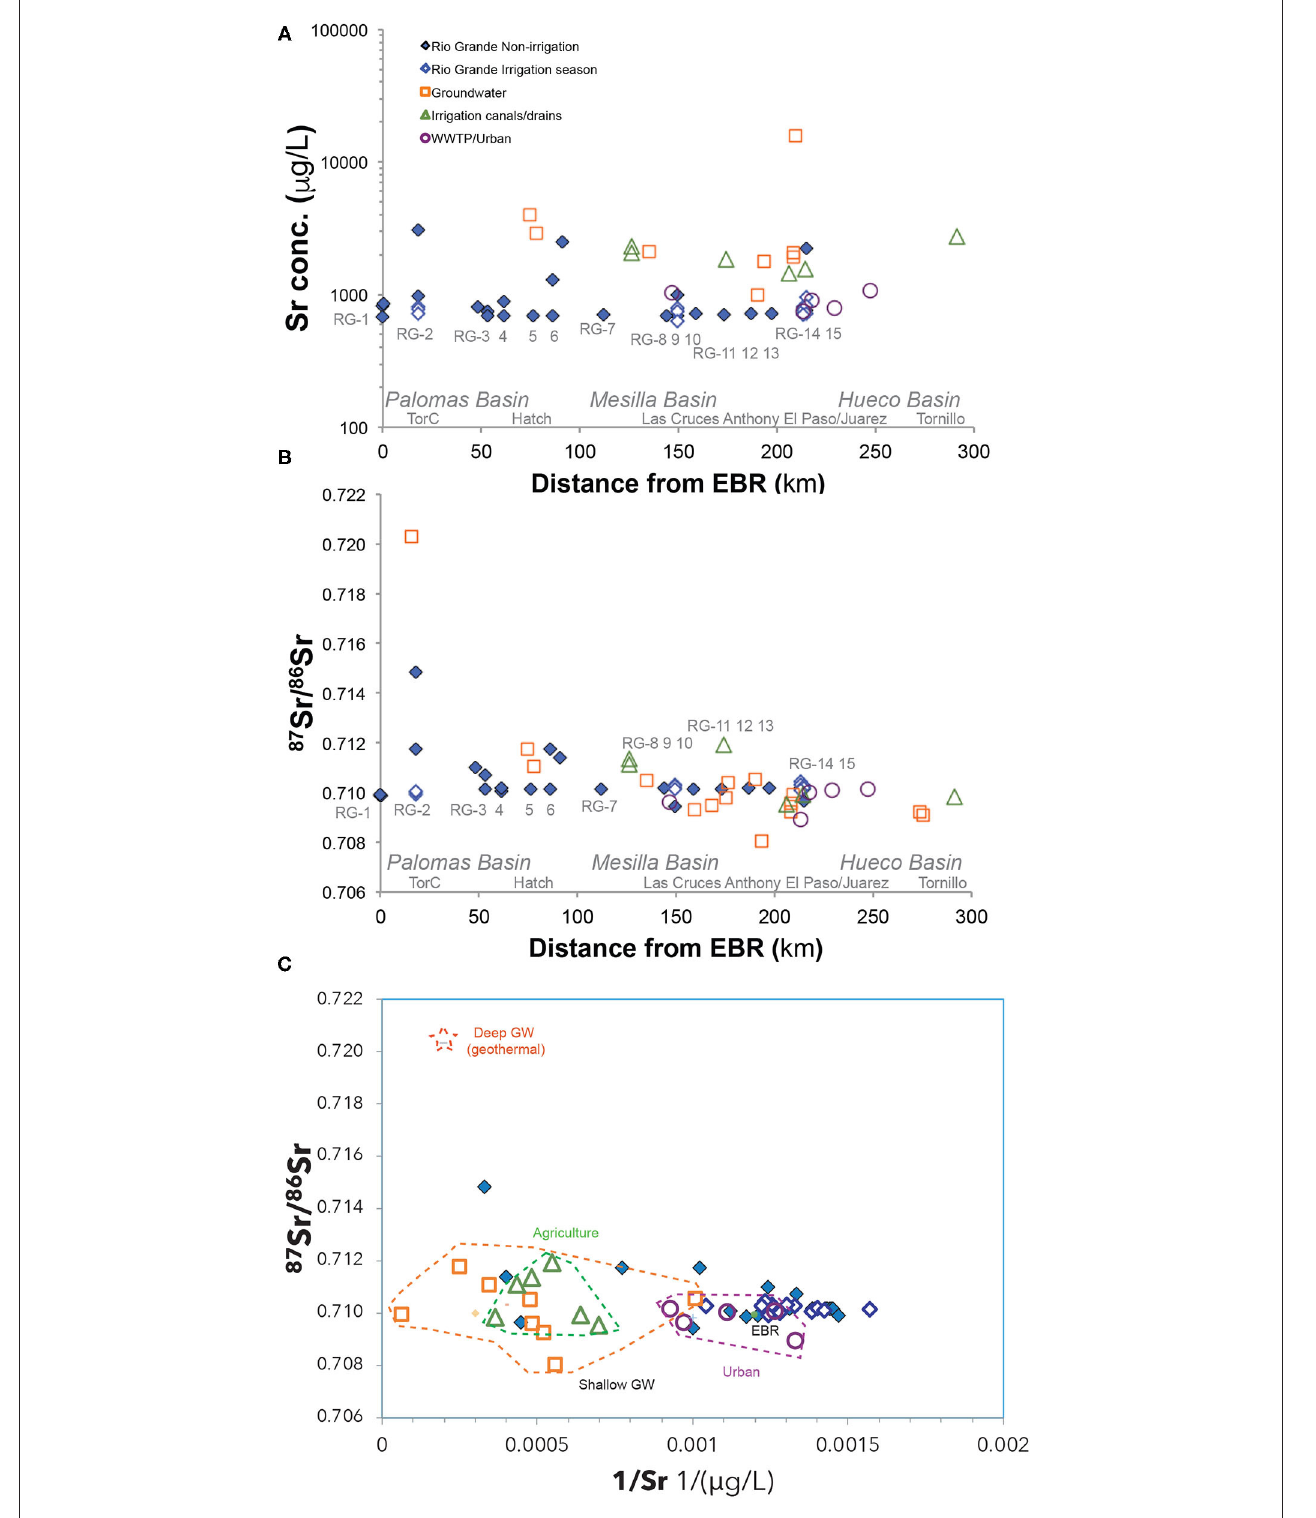
FIGURE 7 | (A) Sr concentrations and (B) 87 Sr/ 86 Sr isotope ratios in the Rio Grande river water, groundwater, agricultural canals and drains, and urban water (waste water treatment plants). The Rio Grande water is divided into non-irrigation and irrigation seasons. The sample locations are placed with distance (km) from Elephant Butte Reservoir along the Rio Grande. (C) 87 Sr/ 86 Sr isotope ratios vs. 1/Sr concentrations. End members for Elephant Butte Reservoir, shallow groundwater, deep groundwater, agricultural water, and urban water are indicated and outlined.